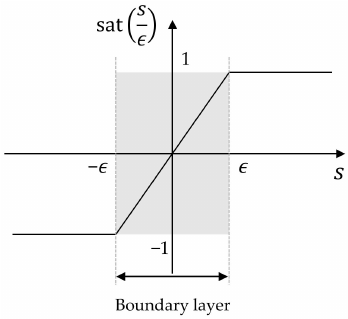
Figure 6. The boundary layer for chattering reduction.